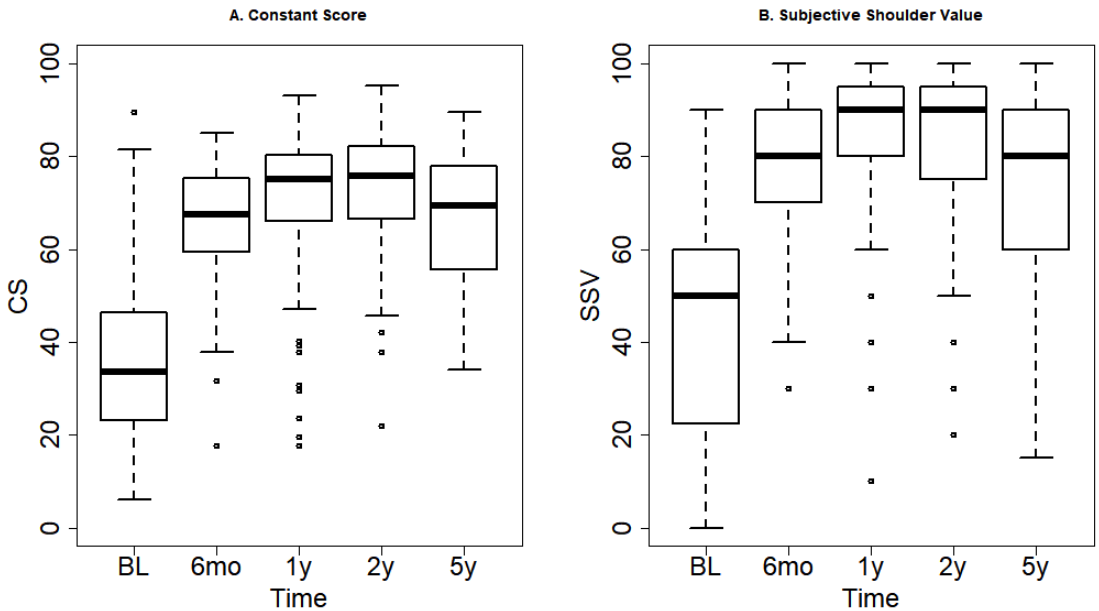
Figure 3. ( A ) Constant score (CS) and ( B ) Subjective shoulder value (SSV) over time. A large and clinically relevant decline is seen at 5 years follow-up for both outcomes. Abbreviations: BL, baseline; mo, months; y, year; CS, constant score; SSV, subjective shoulder value.